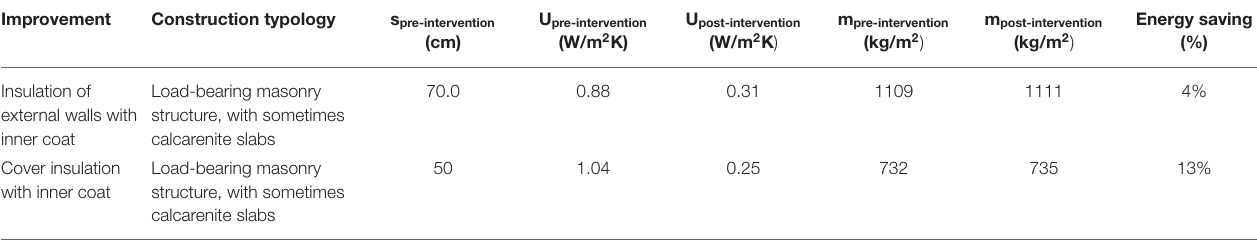
TABLE 5 | Energy saving of insulation of external walls and of cover